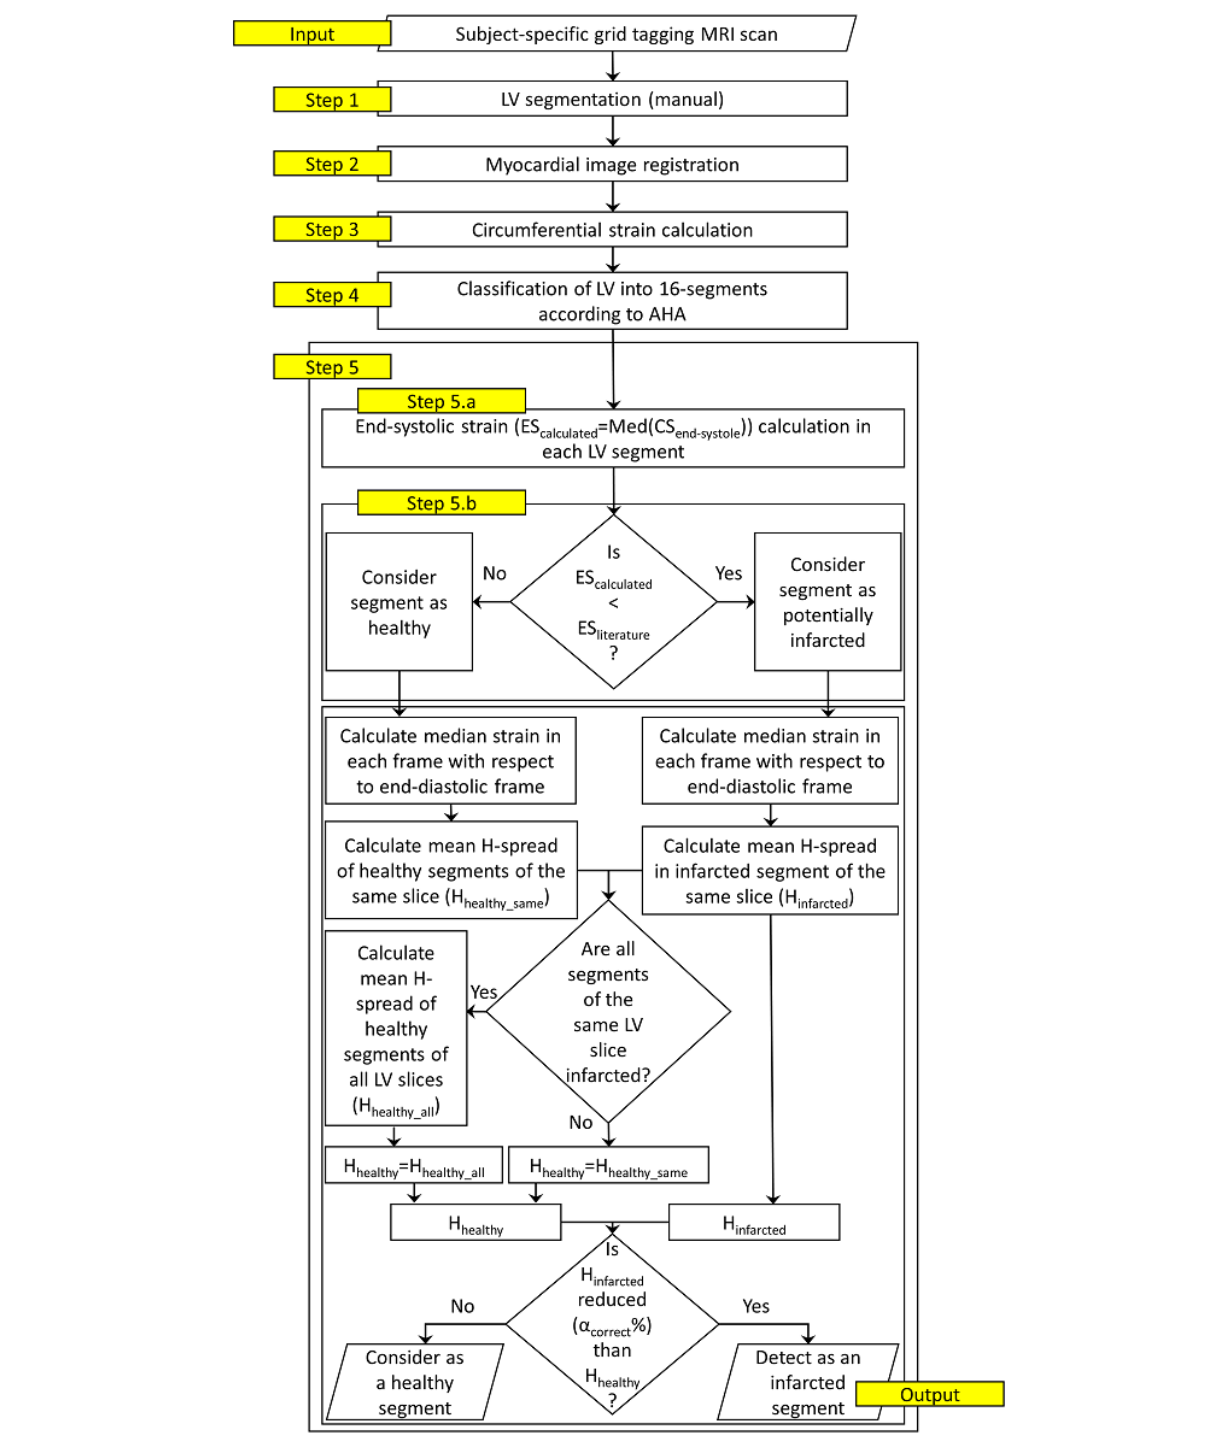
Figure 1. Flowchart of the proposed applied method to identify infarcted LV segments using circumferential strain values. Here, H healthy_same could be H healthy_basal or H healthy_mid or H healthy_apical . HA: American Heart Association; CS: circumferential strain; ES calculated : median of calculated circumferential strain values at the end-systolic frame; ES literature : median of literature referred circumferential strain values at the end-systolic frame; LV: left ventricular or left